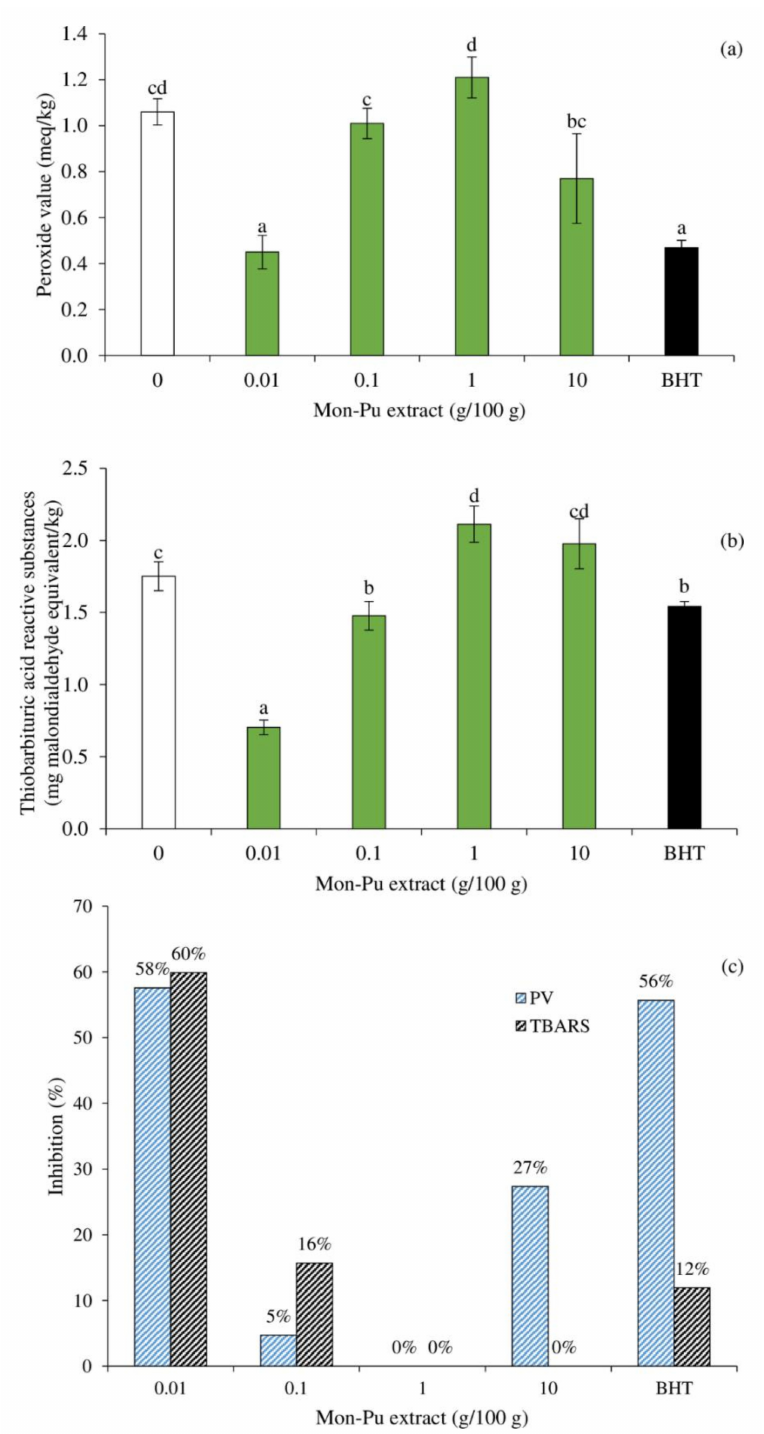
Figure 3. Effect of Mon-Pu leaf extract (MPE) on peroxide value (PV) ( a ), thiobarbituric acid reactive substances (TBARS) ( b ), and lipid oxidation inhibition ( c ) of a cooked sausage model system (SMS). Butylated hydroxyl toluene (BHT) at 0.003% was used to compare. The inhibitions of PV and TBARS were calculated relative to the control without MPE and BHT. Bars represent the standard deviations from triplicate determinations. Different letters indicate the significant differences ( p <